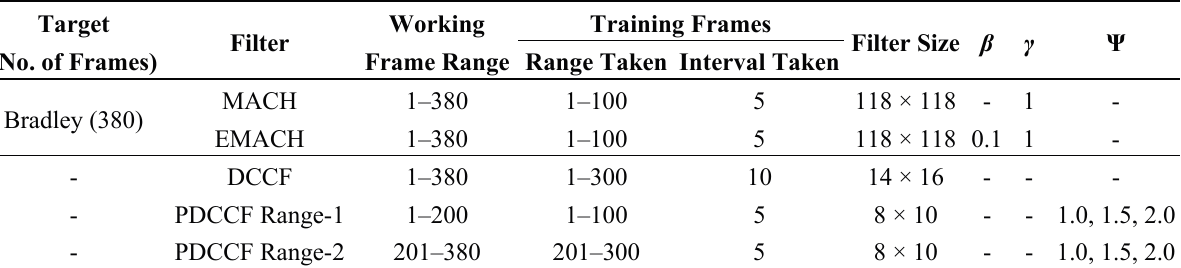
Table 4. Training data for Sequence M1406.